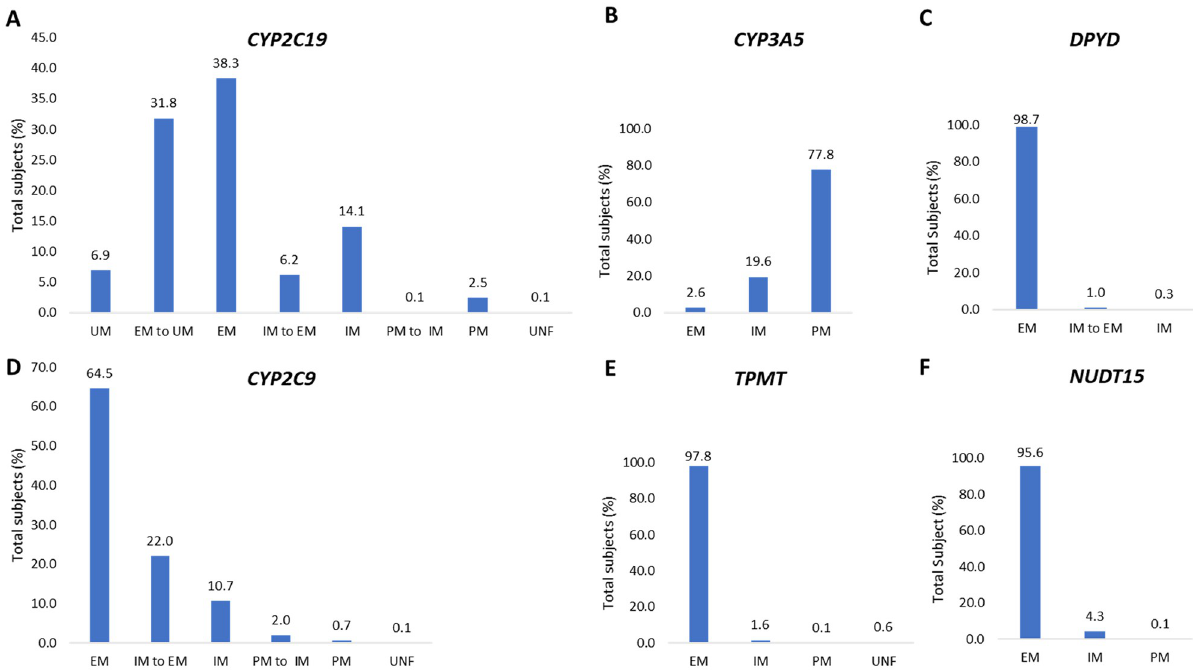
Fig 2. Percentage of the predicted CYP2C19 (A), CYP3A5 (B), DPYD (C), CYP2C9 (D), TPMT (E), NUDT15 (F) metabolizer groups. EM, extensive metabolizer; IM, intermediate metabolizer; PM, poor metabolizer; UM, ultrarapid metabolizer; UNF, uncertain function.